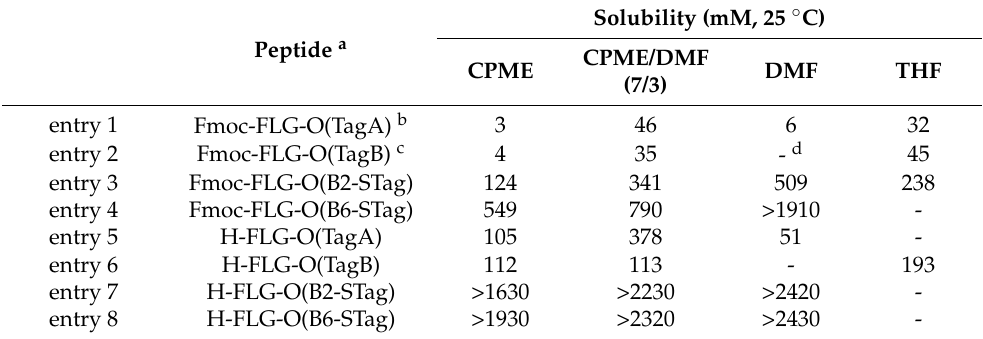
Table 1. Solubility of tagged peptides.